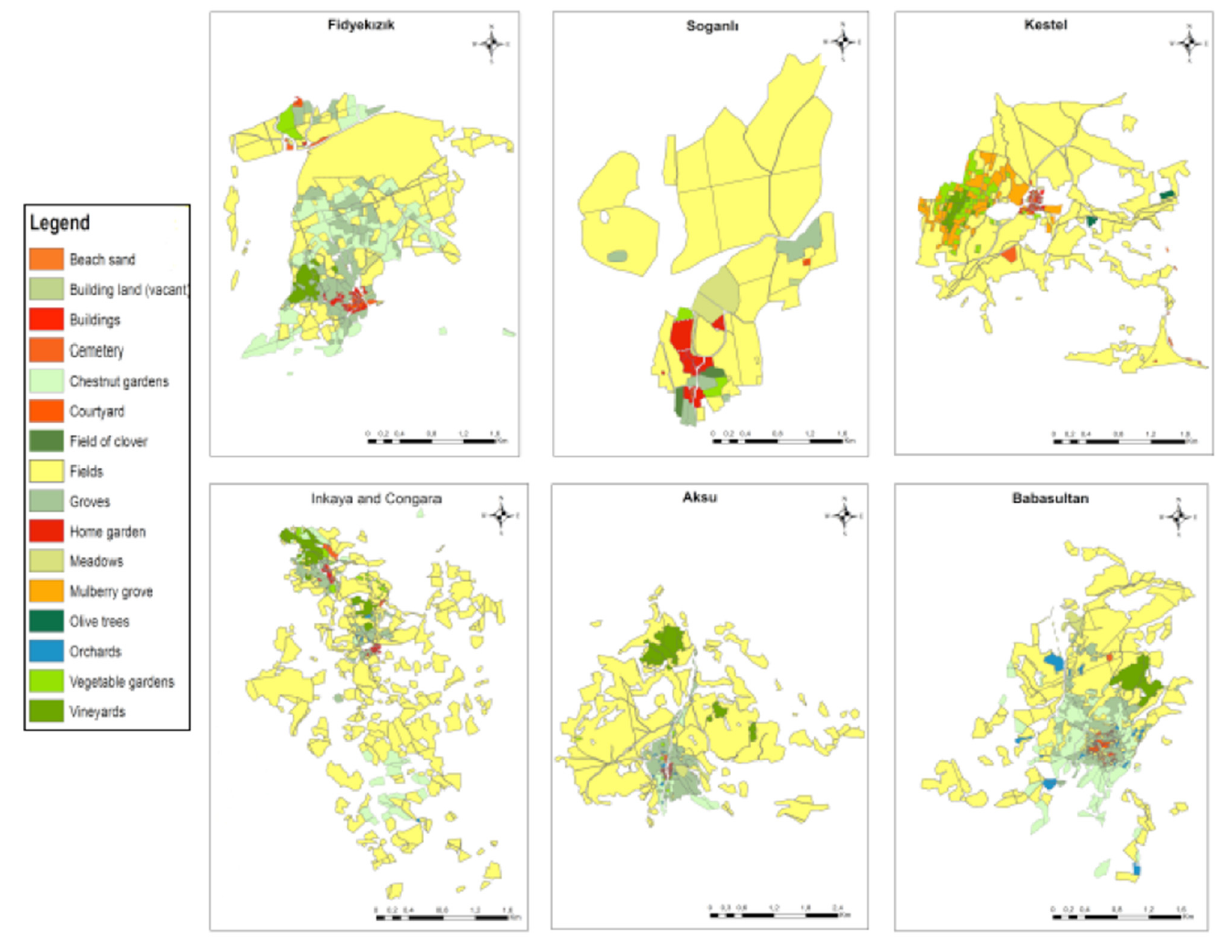
Figure 2. The land cover data for the sampling villages of Bursa in the 1850s. Source: Turkish Presidency State Archives of the Republic of Turkey, Department of Ottoman Archives (HRT.h. 561, 562, 564, 565, 566, 567).